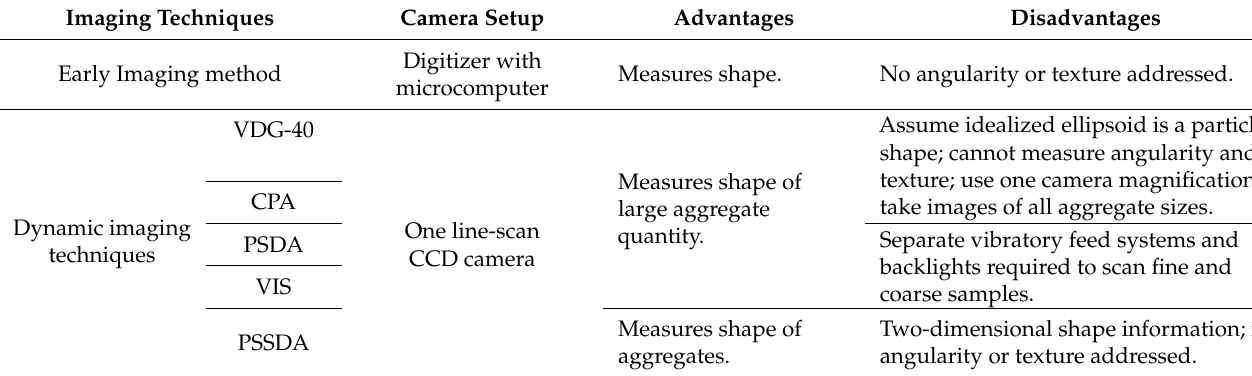
Table 5. Advantages and Disadvantages of Imaging